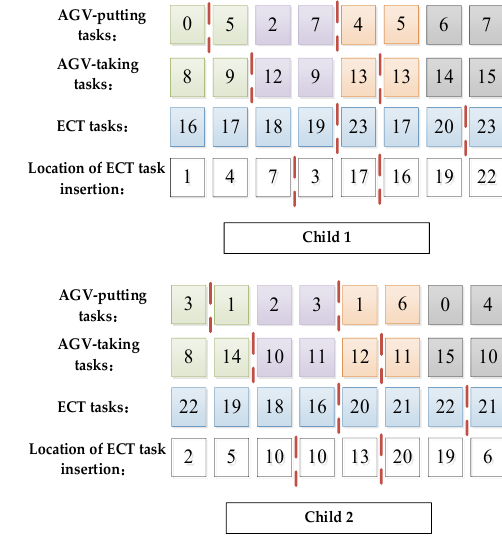
Figure 8. Cross the task sequence.